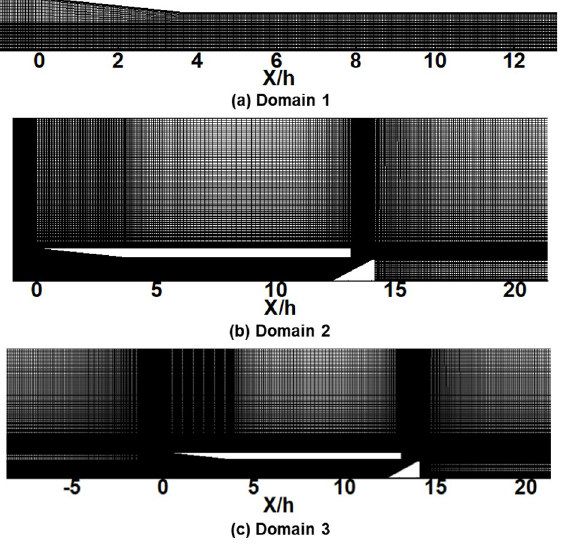
Fig 3. Grid system of the scramjet inlet isolator. (a) Domain 1. (b) Domain 2. (c) Domain 3.